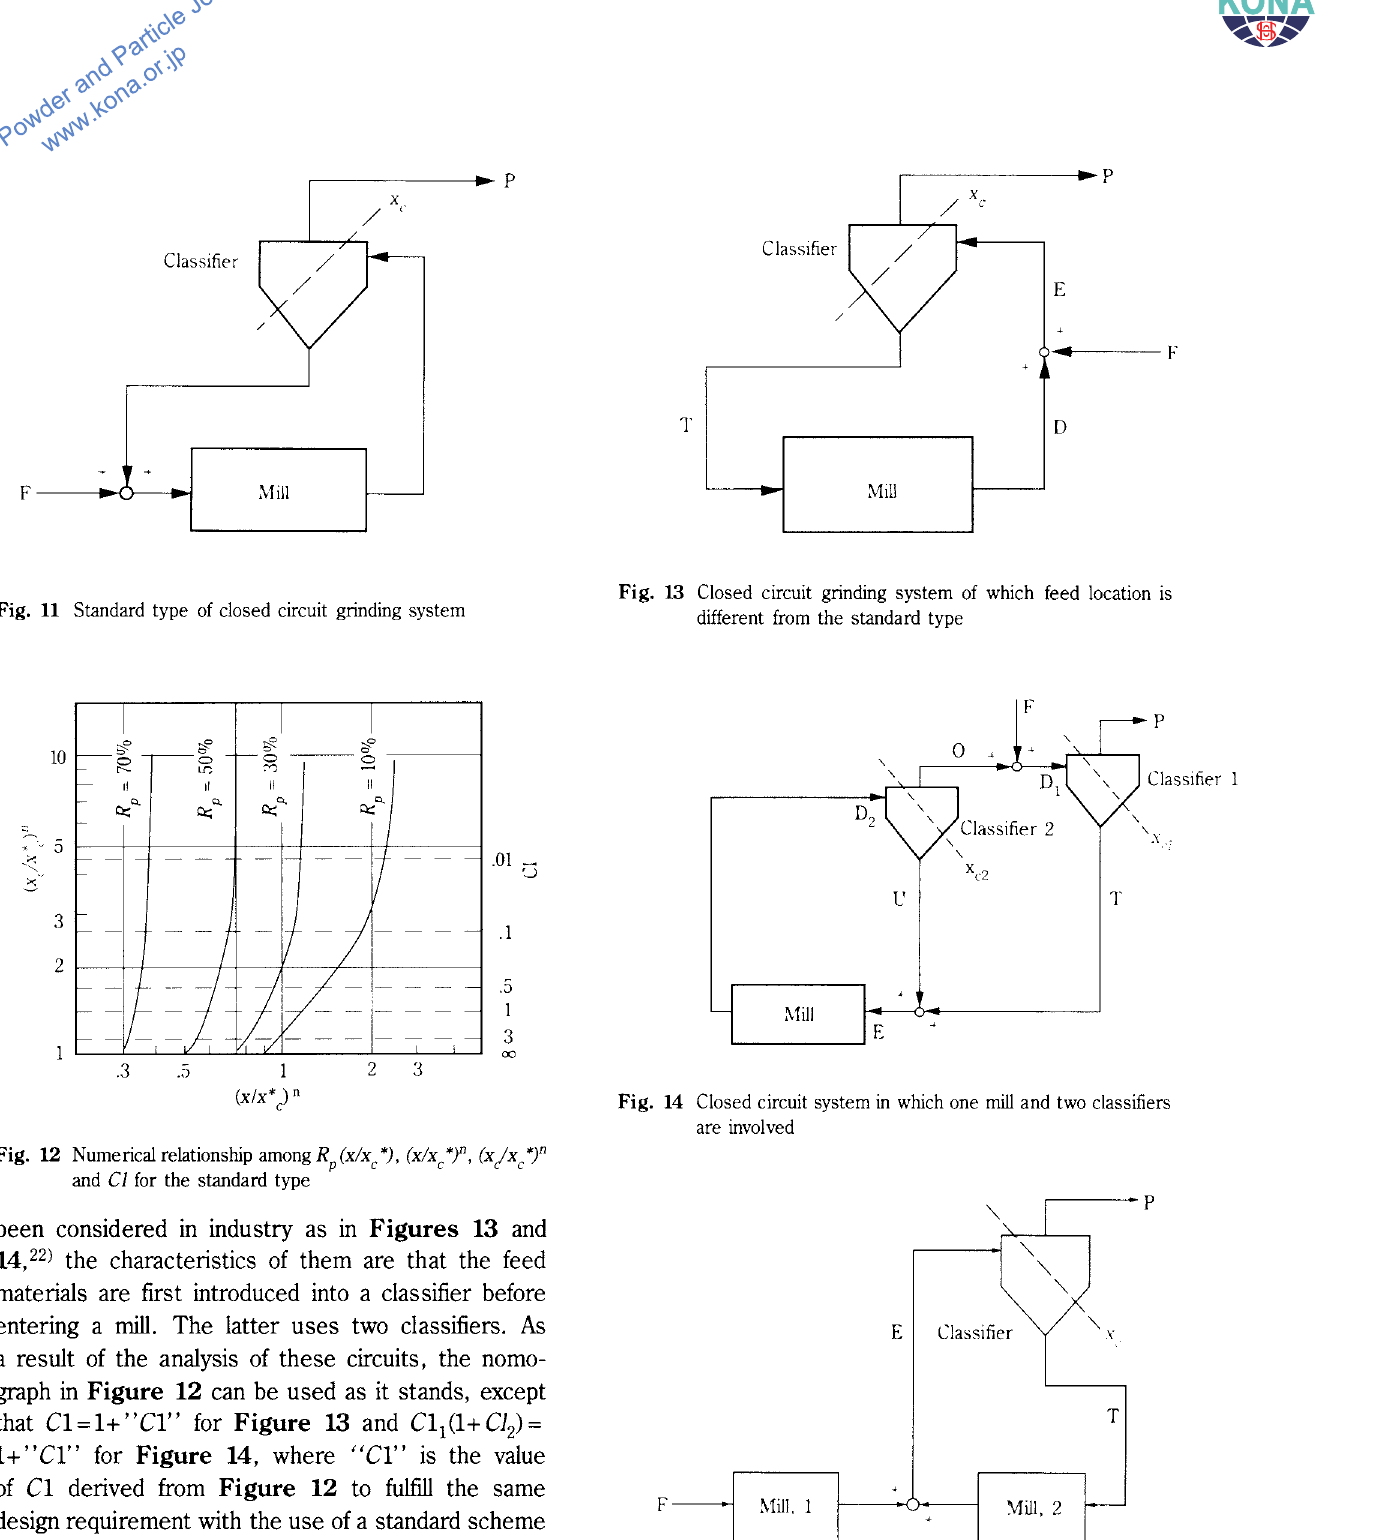
Fig. 15 Closed circuit system in which two mills and one classifier are involved (Type